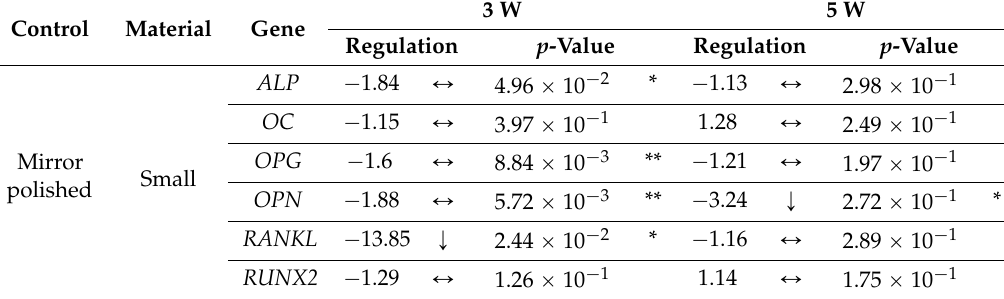
Table 3. The influence of porosity on HDBC gene expression was determined via real-time PCR analyses by normalising each material (Small, Medium, Mixed, and Large) to the mirror polished (MP) sample (control) ( ∆∆ C t ) after three weeks (3 W) and five weeks (5 W). Regulation: fold expression values are compared to regulation threshold ( Ò up regulation, Ó down regulation, and Ø no